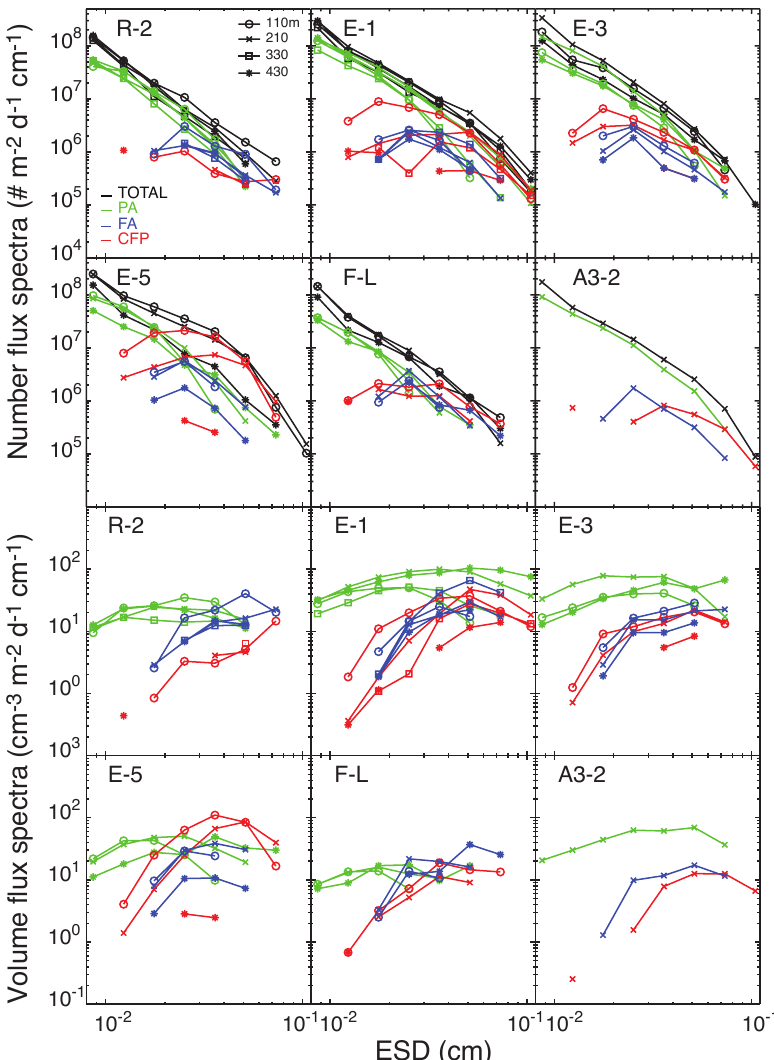
Figure 7. Total number and volume fluxes of particles binned in 10 size classes. Bins with less than five particles were removed (see Table 2 and text for explanations). Results are shown for each category of particles at all depths and sites. TOTAL: all particles; PA: phytodetrital aggregates; FA: fecal aggregates; CFP: cylindrical fecal pellets. Smallest particles represented by phytodetrital aggregates were the most numerous at every site and depth. Middle-sized phytodetrital aggregates and fecal particles (pellets and aggregates) contributed the most to the volume flux due to the overall rarity of very large particles relative to all